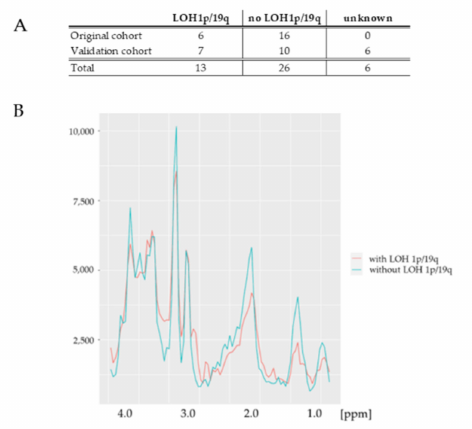
Figure 5. LOH 1p/19q status in the original and validation cohort in the IDH mut subgroup. ( A ) Dis- tribution of LOH 1p/19q status in the original, validation, and total cohort. ( B ) Averaged spectra of IDH mut group with LOH 1p/19q (marked in red, n = 13) and of IDH mut group without LOH 1p/19q (marked in green, n = 26) in the total cohort. LOH: loss of heterozygosity; IDH : isocitrate dehydrogenase; mut: